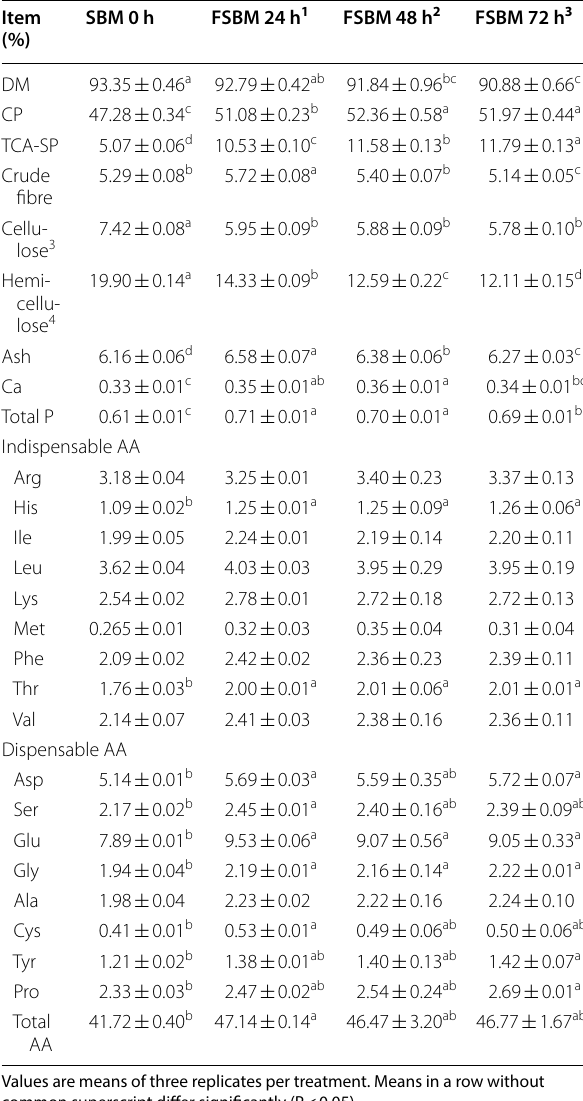
Table 2 Analyzed nutrient composition of uninoculated SBM and FSBM during two-stage